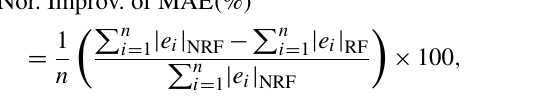
Figure 1. Map of the distribution of the AERONET (points) and the EARLINET (star)